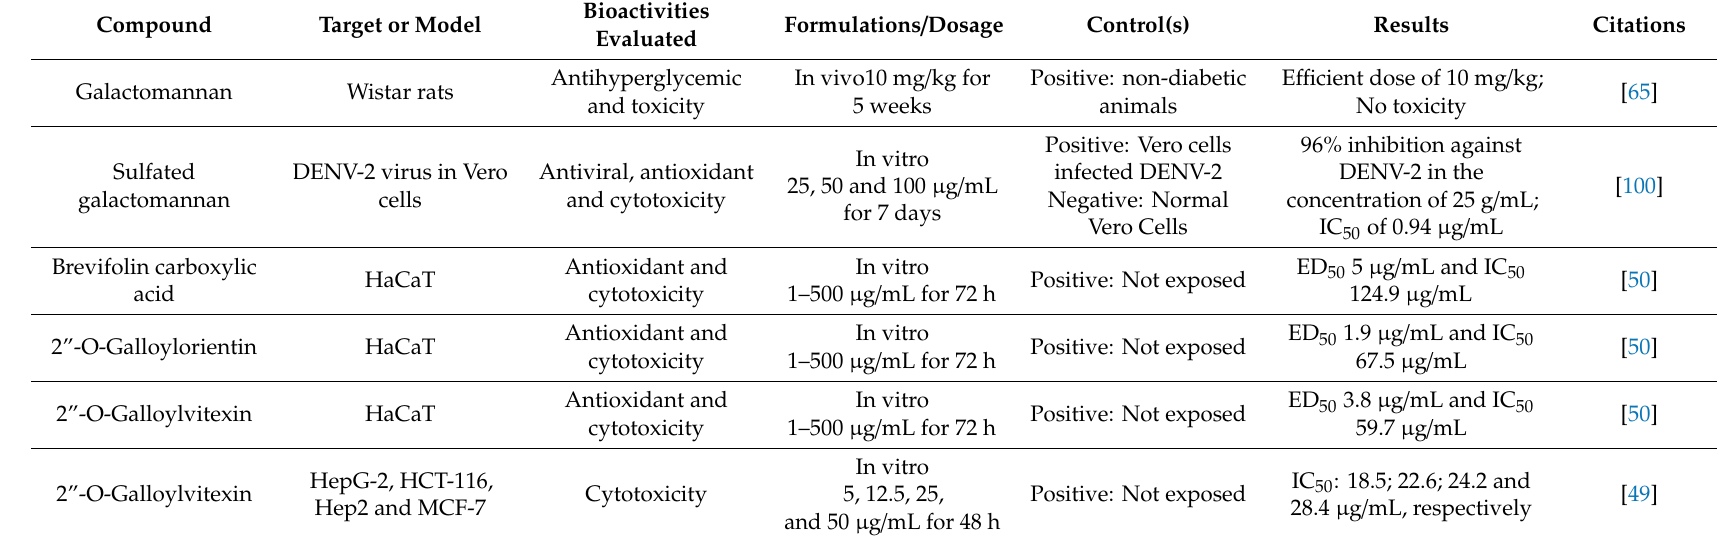
Table 5. Biological activities of compounds isolated from C. ferrea